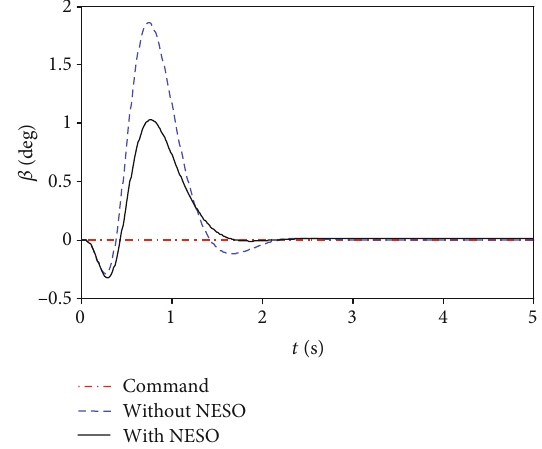
Figure 7: Sideslip angle tracking diagram.